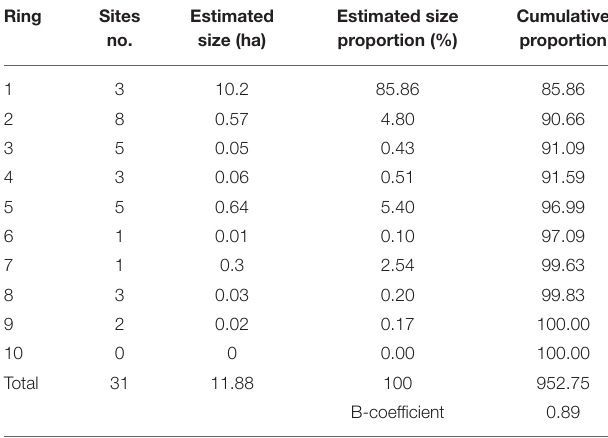
TABLE 9 | Calculation of B-coefficient for Murlo in the Iron Age/Orientalizing period. Ring Sites